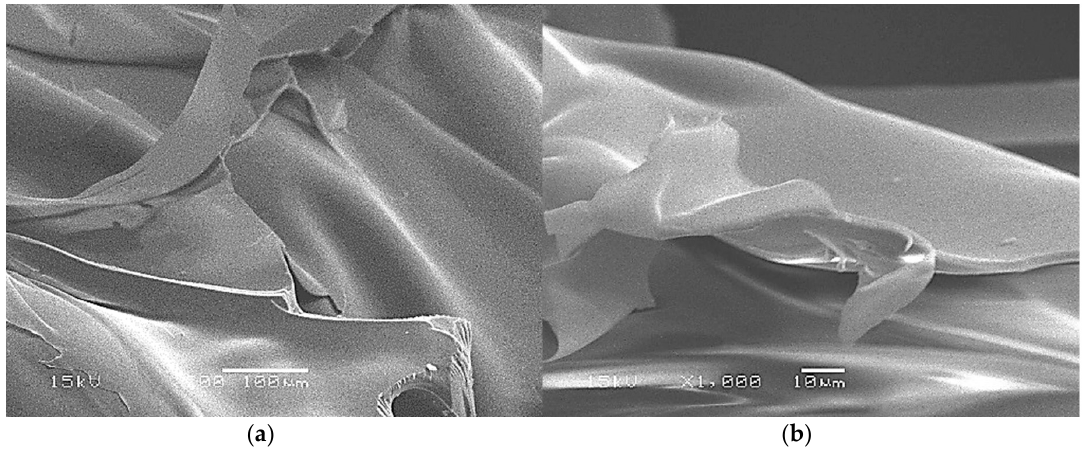
Figure 7. Plasticized starch SEM micrographs: ( a ) × 200; ( b ) × 1000.